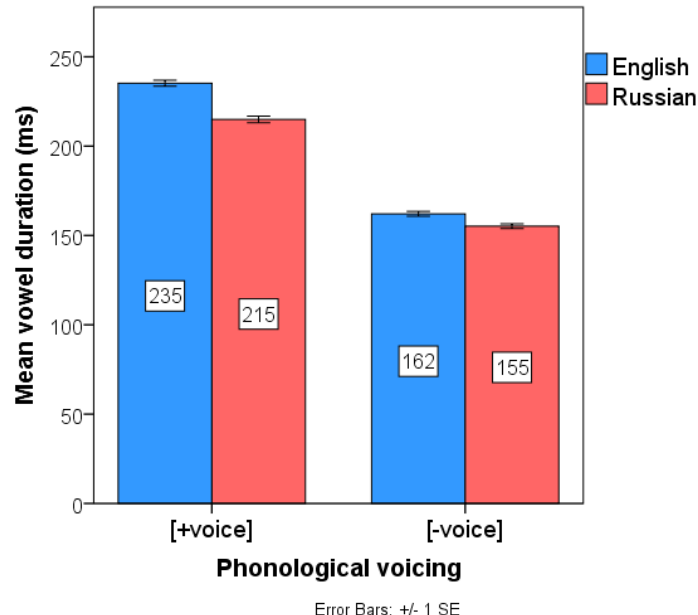
Figure 11. Mean vowel duration before voiced and voiceless final obstruents in learners’ English and Russian.